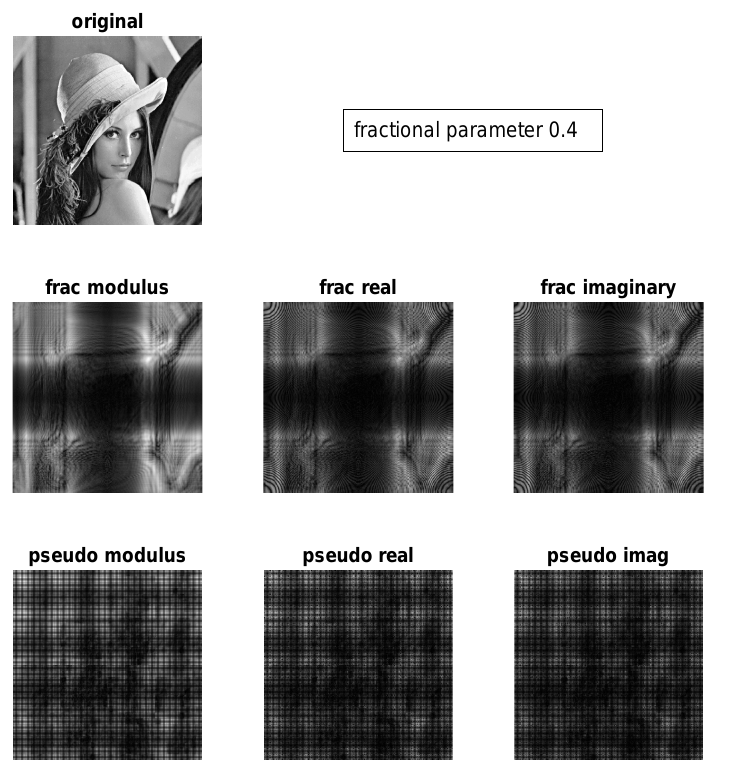
Figure 7. Comparison of DFrFT and DPFrFT of the grayscale image “Lena” for fractional parameter a = 0.4.